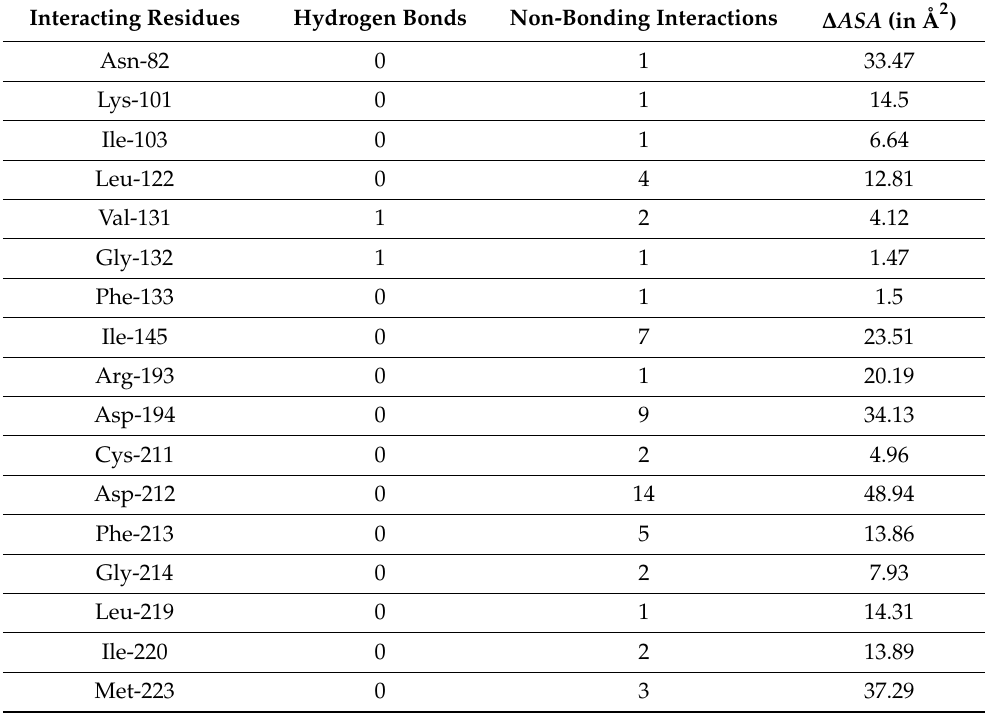
Table A8. The MEK2 residues interacting with selected flavonoid M2F8 are listed with the number of non-bonding interactions and ∆ ASA .